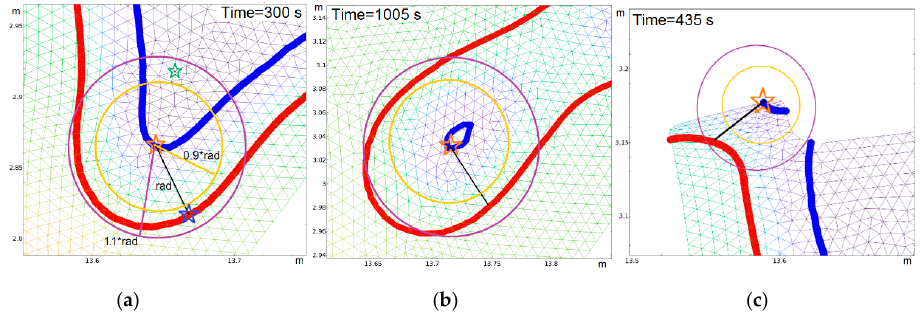
Figure 21. Determination of the filled nodes that surround the considered one at the time t 01 ( i ) when it starts filling. The situations in the pictures ( a – c ) correspond to the same typical ones in Figure 20.